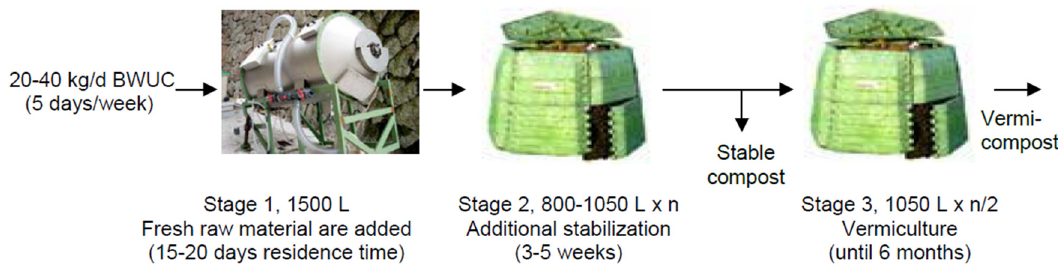
Figure 6. Composting process diagram at the School of Architecture. The static maturity composter (SMC) in stage 2 could be replaced with a breathable bag (big-bag). The number of units in parallel in stage 2 ranged between 2 and 4.